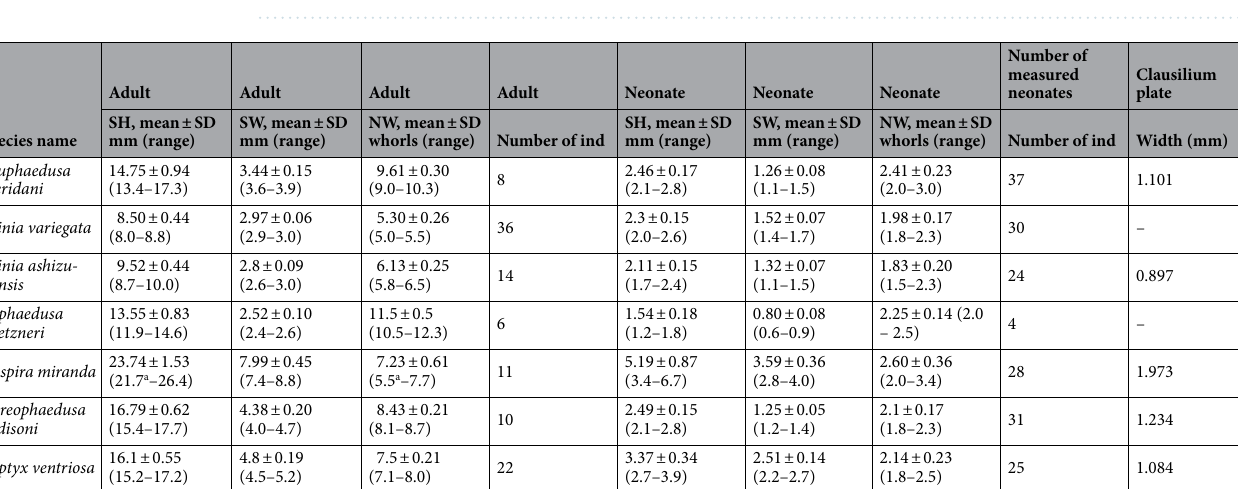
Figure 3. Two types of clausiliar apparatus occurring in Phaedusinae in microCT visualisation: with spirally ascending inferior lamella and wide clausilium plate (upper row), and with straight ascending inferior lamella and narrow clausilium plate (lower row). ( A ) T. sheridani adult shell with the body whorl cut open dorsally; ( B ) clausilium of T. sheridani ; ( C ) clausilium of S. addisoni ; ( D ) clausilium of R. ashizuriensis ; ( E ) Zaptyx ventriosa adult shell with body whorl cut open dorsally; ( F ) clausilium of Z. ventriosa ; ( G,H ) clausilia of O. miranda. Note, that all depicted species are viviparous.